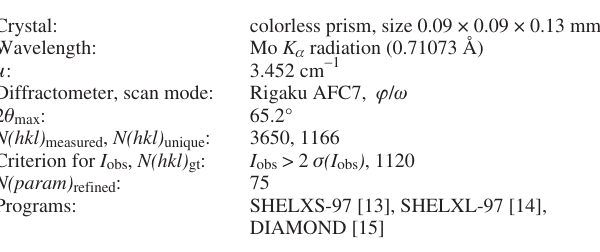
Table 1. Data collection and handling.